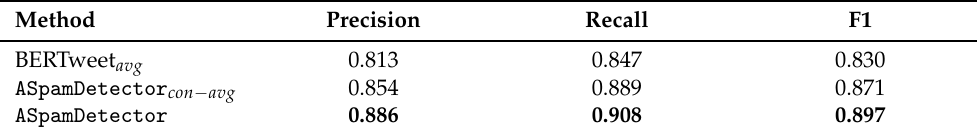
Table 4. Validating the importance of the proposed content-based attention mechanism.